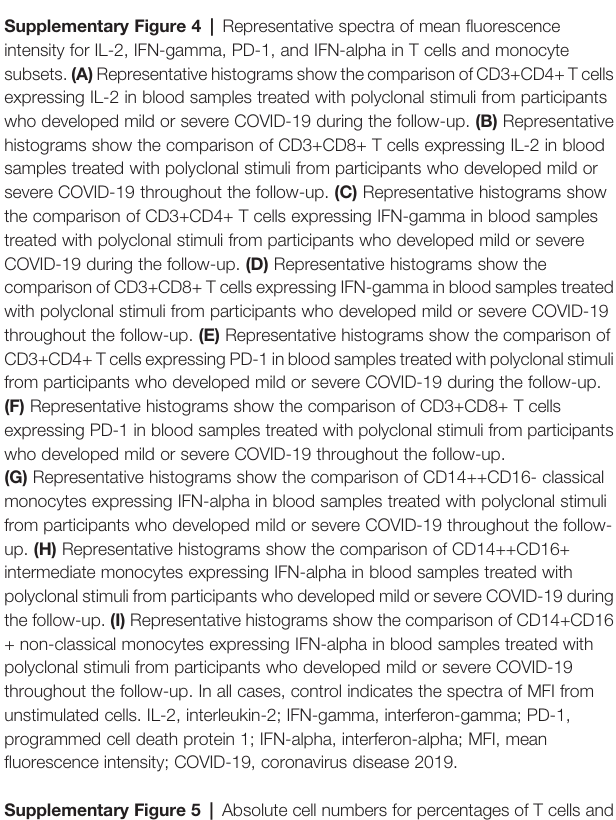
Supplementary Figure 3 | Gating strategy for monocyte subsets. Gating strategy for selecting primary human HLA-DR+ monocyte subsets and measuring IFN-alpha precisely. FSC-H, forward scatter height; FSC-A, forward scatter area; SSC-A, side scatter area; HLA-DR, human leukocyte antigen-DR isotype; IFN-alpha. Supplementary Figure 4 | Representative spectra of mean fl uorescence intensity for IL-2, IFN-gamma, PD-1, and IFN-alpha in T cells and monocyte subsets. (A) RepresentativehistogramsshowthecomparisonofCD3+CD4+Tcells expressing IL-2 in blood samples treated with polyclonal stimuli from participants who developed mild or severe COVID-19 during the follow-up. (B) Representative histograms show the comparison of CD3+CD8+ T cells expressing IL-2 in blood samples treated with polyclonal stimuli from participants who developed mild or severe COVID-19 throughout the follow-up. (C) Representative histograms show the comparison of CD3+CD4+ T cells expressing IFN-gamma in blood samples treated with polyclonal stimuli from participants who developed mild or severe COVID-19 during the follow-up. (D) Representative histograms show the comparison of CD3+CD8+ T cells expressing IFN-gamma in blood samples treated with polyclonal stimuli from participants who developed mild or severe COVID-19 throughout the follow-up. (E) Representative histograms show the comparison of CD3+CD4+TcellsexpressingPD-1inbloodsamplestreatedwithpolyclonalstimuli from participants who developed mild or severe COVID-19 during the follow-up. (F) Representative histograms show the comparison of CD3+CD8+ T cells expressing PD-1 in blood samples treated with polyclonal stimuli from participants who developed mild or severe COVID-19 throughout the follow-up. (G) Representative histograms show the comparison of CD14++CD16- classical monocytes expressing IFN-alpha in blood samples treated with polyclonal stimuli from participants who developed mild or severe COVID-19 throughout the follow- up. (H) Representative histograms show the comparison of CD14++CD16+ intermediate monocytes expressing IFN-alpha in blood samples treated with polyclonal stimuli from participants who developed mild or severe COVID-19 during the follow-up. (I) Representative histograms show the comparison of CD14+CD16 + non-classical monocytes expressing IFN-alpha in blood samples treated with polyclonal stimuli from participants who developed mild or severe COVID-19 throughout the follow-up. In all cases, control indicates the spectra of MFI from unstimulated cells. IL-2, interleukin-2; IFN-gamma, interferon-gamma; PD-1, programmed cell death protein 1; IFN-alpha, interferon-alpha; MFI, mean fl uorescence intensity; COVID-19, coronavirus disease 2019. Supplementary Figure 5 | Absolute cell numbers for percentages of T cells and monocyte subsets. We show absolute cell numbers for percentages of CD3+CD4+ T cells expressing IL-2, IFN-gamma, and PD-1 on top. We show absolute cell numbers for percentages of CD3+CD8+ T cells expressing IL-2, IFN-gamma, and PD-1 in the middle. We show absolute cell numbers for percentages of classical, intermediate, and non-classical monocytes expressing IFN-alpha on the bottom. We de fi ned classical monocytes as CD14++CD16-, intermediate monocytes as CD14++CD16+, and non-classical monocytes as CD14+CD16+. We expressed data as mean ± standard deviation. We compared data using the unpaired Student ’ s T-test and considered differences signi fi cant when P < 0.05.